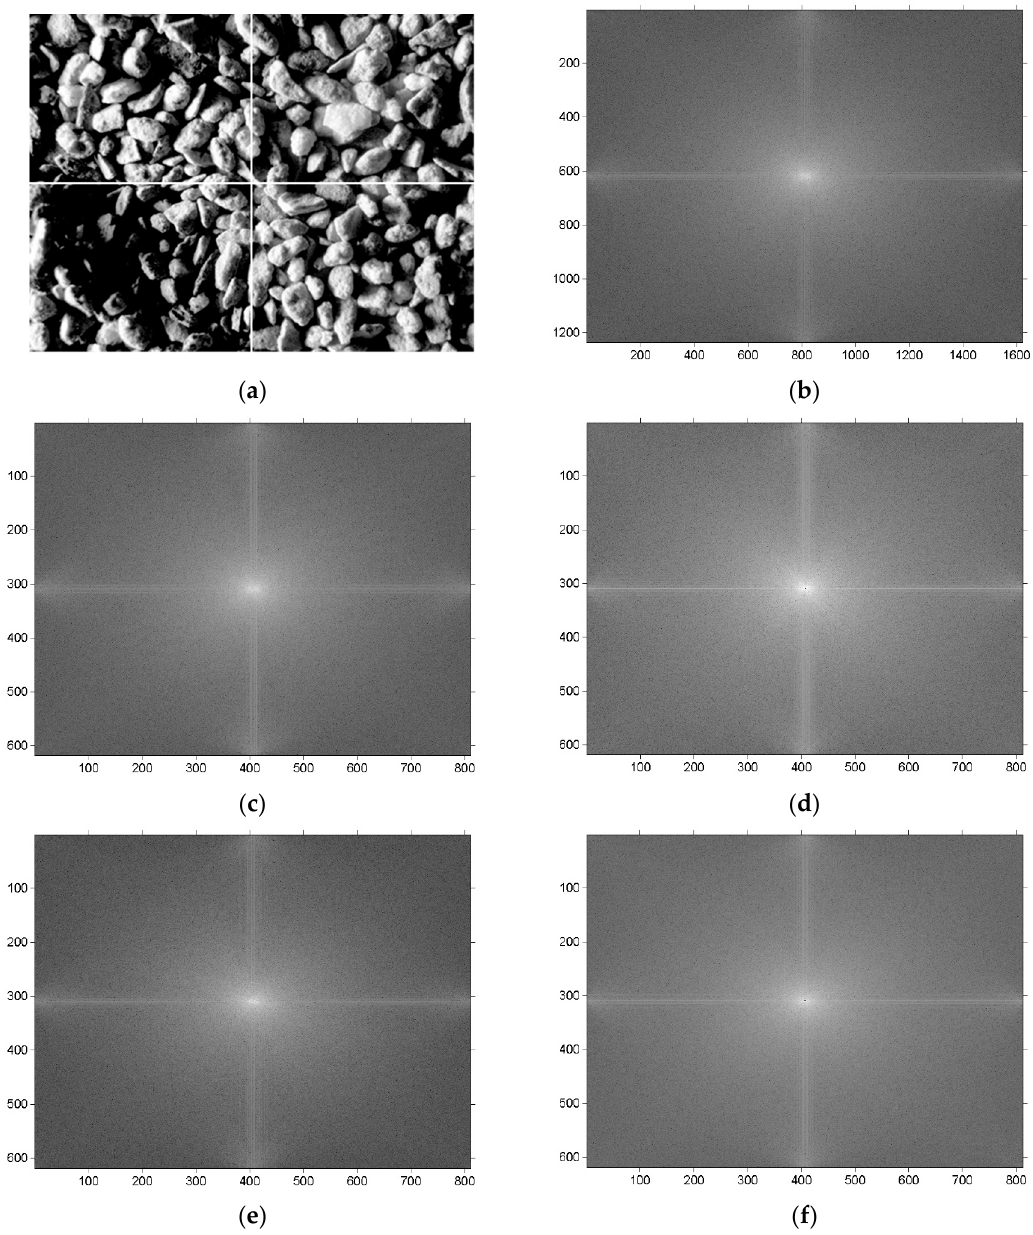
Figure 4. Image of the sample after HE with a marked sub-region ( a ), 2DFFT result ( b ), 2DFFT result for the top-left sub-region ( c ), 2DFFT result for the top-right sub-region ( d ), 2DFFT result for the bottom-left sub-region ( e ), 2DFFT result for the bottom-right sub-region ( f ).